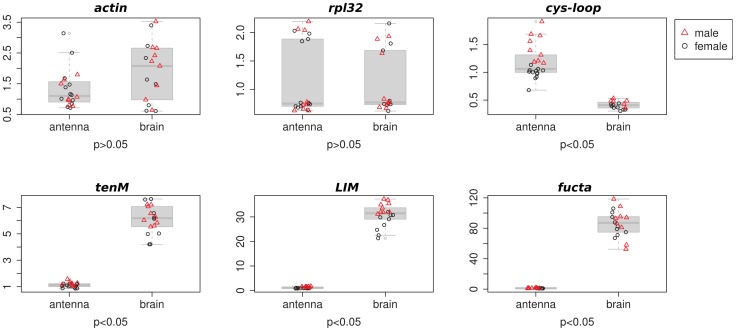
Gene expression for 2 housekeeping genes (actin and rpl32) and 4 candidate genes.Red triangles display male samples. Black circles display female samples. P-values indicate whether the gene is significantly differentially expressed between brain and antenna samples. * display genes which harbor a sex-biased expression.